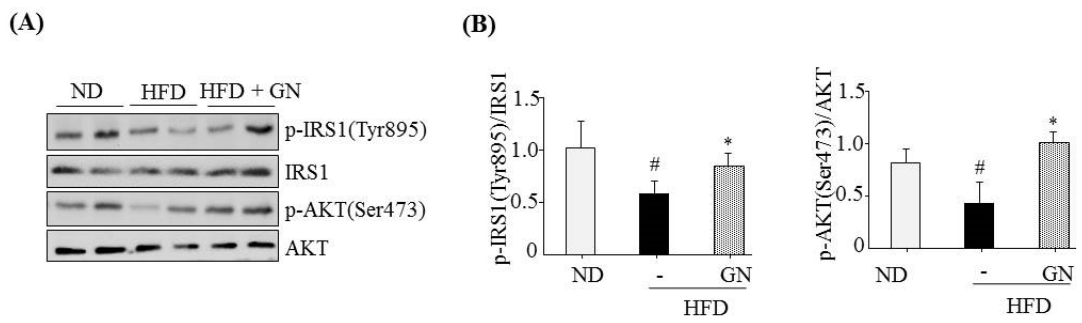
Figure 7. GN reversed HFD-mediated inhibition of insulin signaling in the liver of HFD obese mice. C57BL6 mice were fed HFD for 12 weeks and orally administered GN for 6 weeks. The liver homogenates were subjected to western blot using indicated antibody. ( A ) Representative western blotting. ( B ) Densitometric results. The values are expressed as mean ± SEM ( n = 5 mice per group). # p < 0.05 vs. ND mice. * p < 0.05 vs. HFD-induced obese mice control. ND; normal diet.